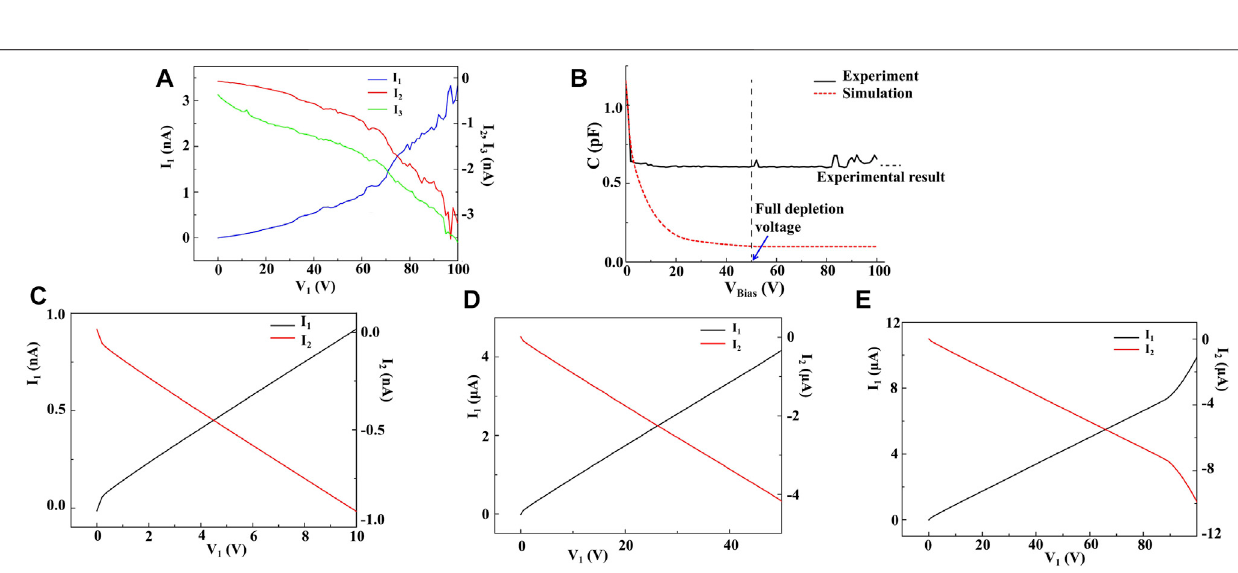
Frontiers in Materials |